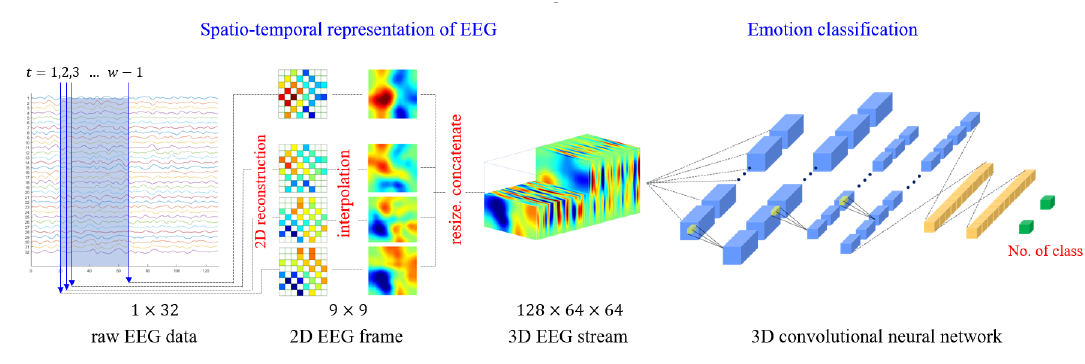
Figure 1. Overview of the proposed